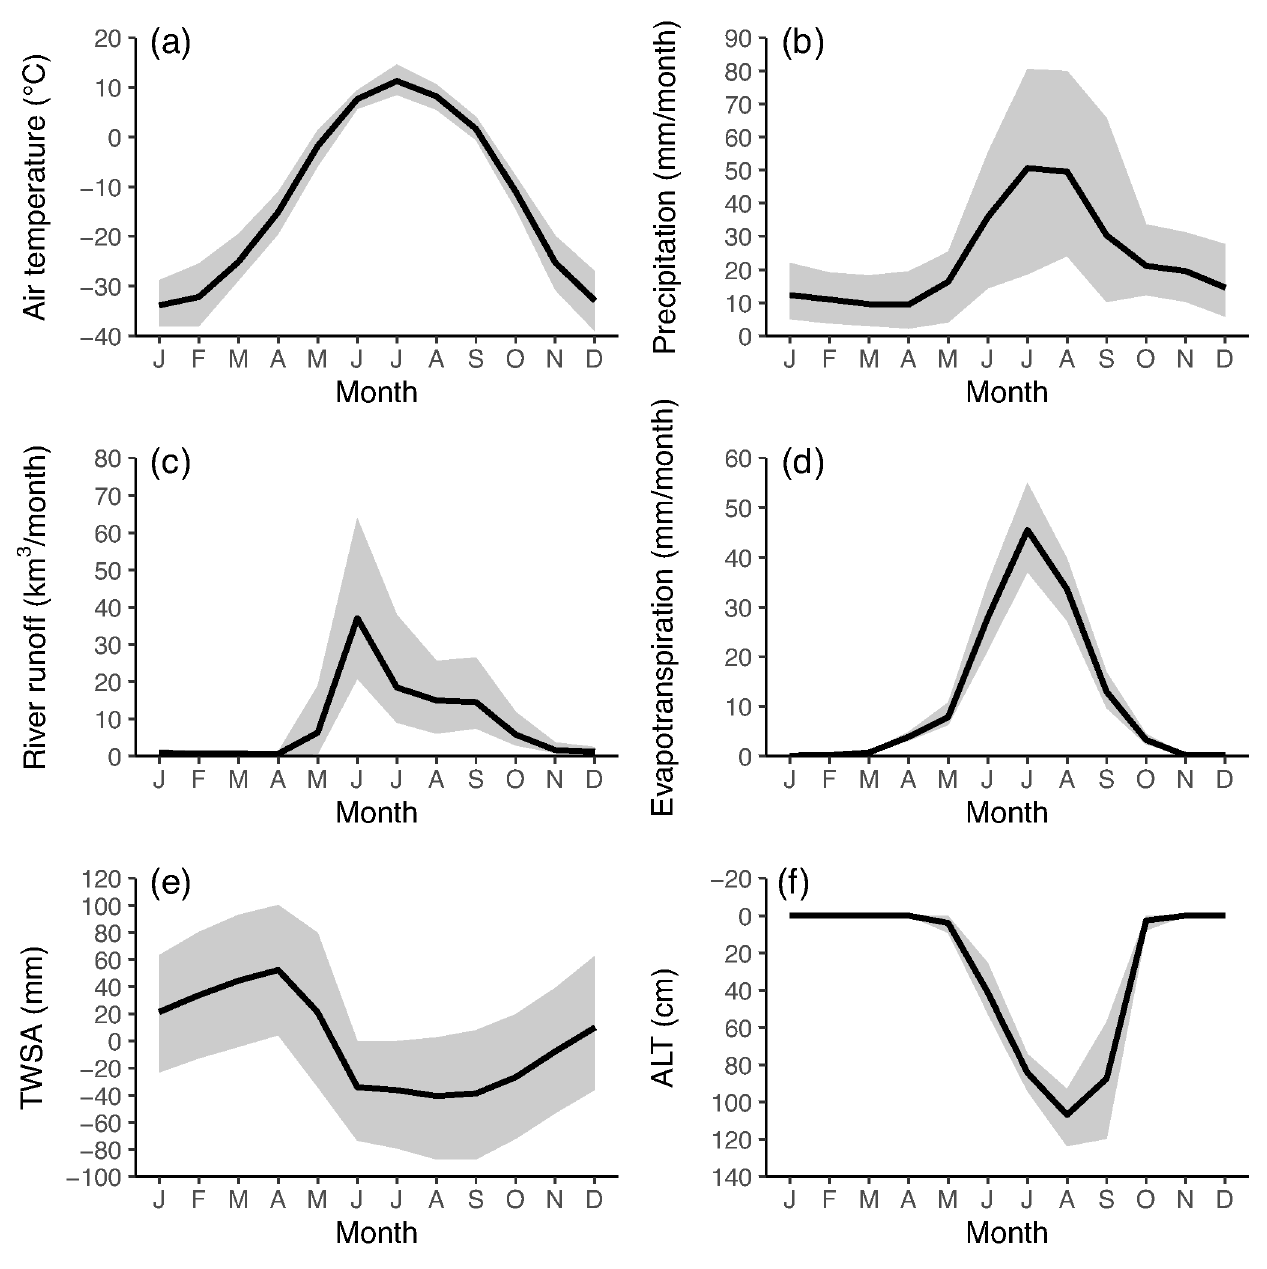
Figure 10. Basin-averaged climatology of the seasonal variations in monthly hydrometeorological factors: ( a ) Air tempera- ture; ( b ) precipitation; ( c ) river runoff; ( d ) evapotranspiration; ( e ) terrestrial water storage anomaly (TWSA), and ( f ) active layer thickness (ALT); ( d – f ) are CHANGE-based products. Gray areas represent the interannual variability of 95%